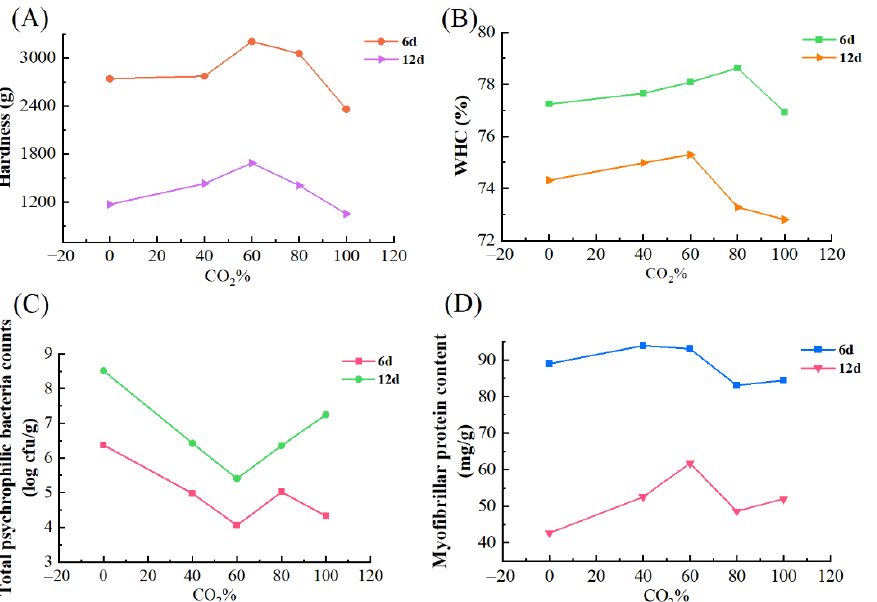
Figure 7. Relationship between CO 2 concentrations and hardness ( A ), WHC ( B ), TPB ( C ), and myofibrillar protein content ( D ) of salmon fillets stored under modified atmosphere packaging containing O 2 of 0% at 4 °C on 6 d and 12 d.